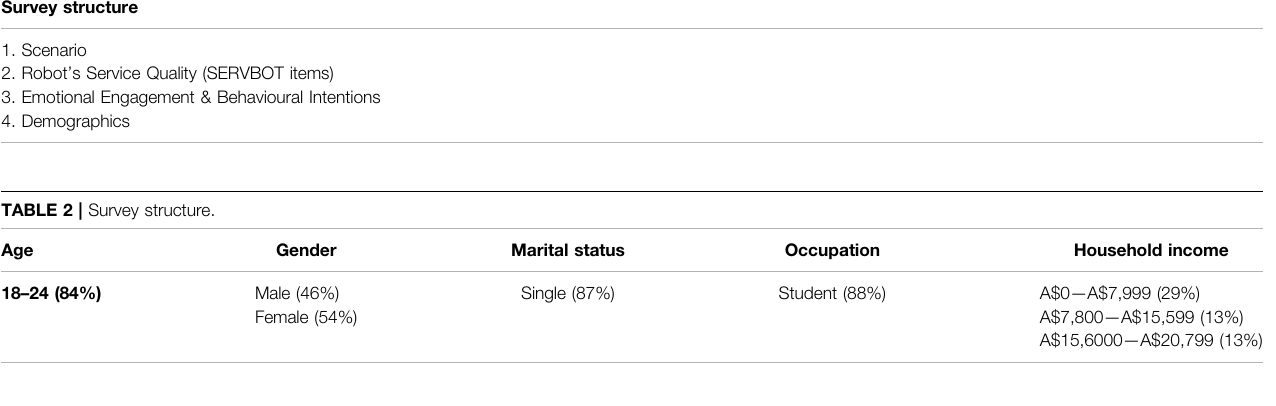
TABLE 3 | Factor analysis & reliability test.